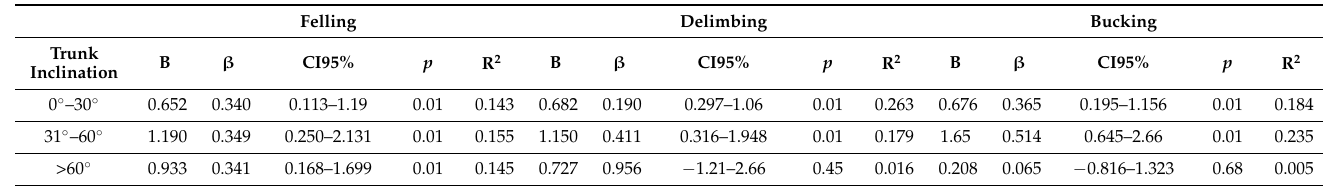
Table 7. Linear regression model: trunk inclination classifications as predictive variables associated with %RHR in the total sample ( n = 40) for the three tasks of felling, delimbing, and